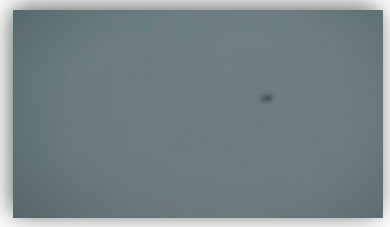
Figure 16. Results of the tracing test on rainy days (drone flight altitude is 80